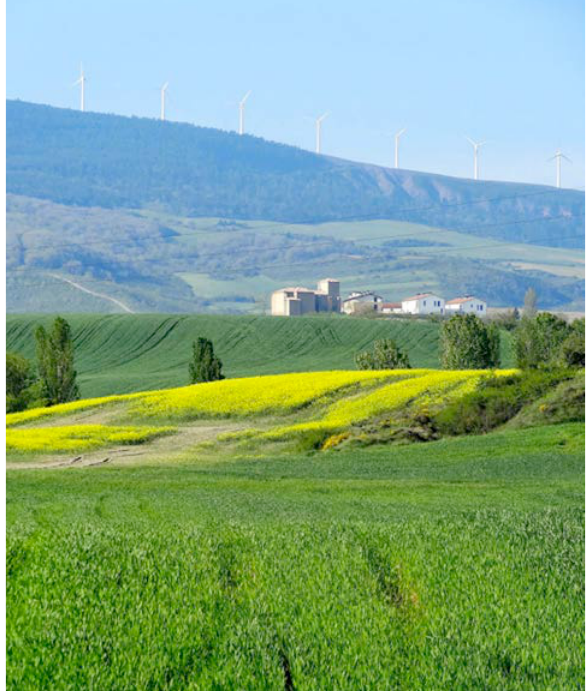
Figure 3. The Wind Farm as perceived from the northern slope of the Sierra de Erreniega. The village is Zariquiegui, a 12 th century settlement on the Spanish French